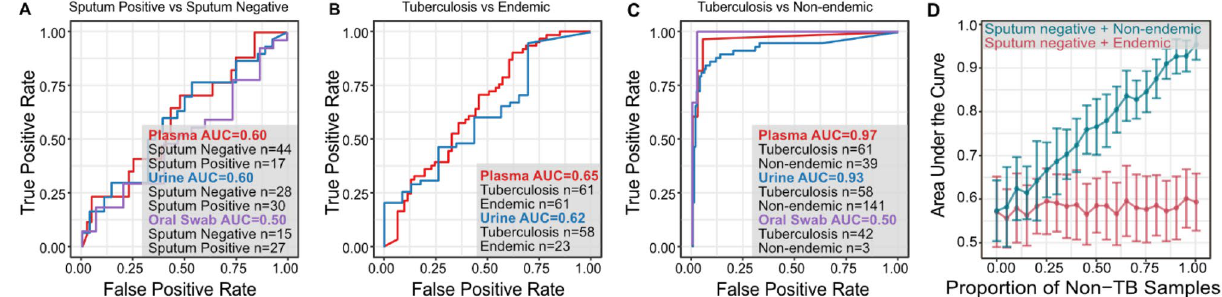
Figure 3. The performance of the metagenomic assay in discriminating ( A ) sputum positive versus sputum negative samples, ( B ) tuberculosis versus endemic cohorts, and ( C ) tuberculosis versus non-endemic cohorts (AUC = area under the curve). ( D ) Evaluating the effects of incorporating non-endemic samples (blue) and endemic samples (red) on the diagnostic performance via simulation show that the inclusion of non-endemic samples skews the assay’s